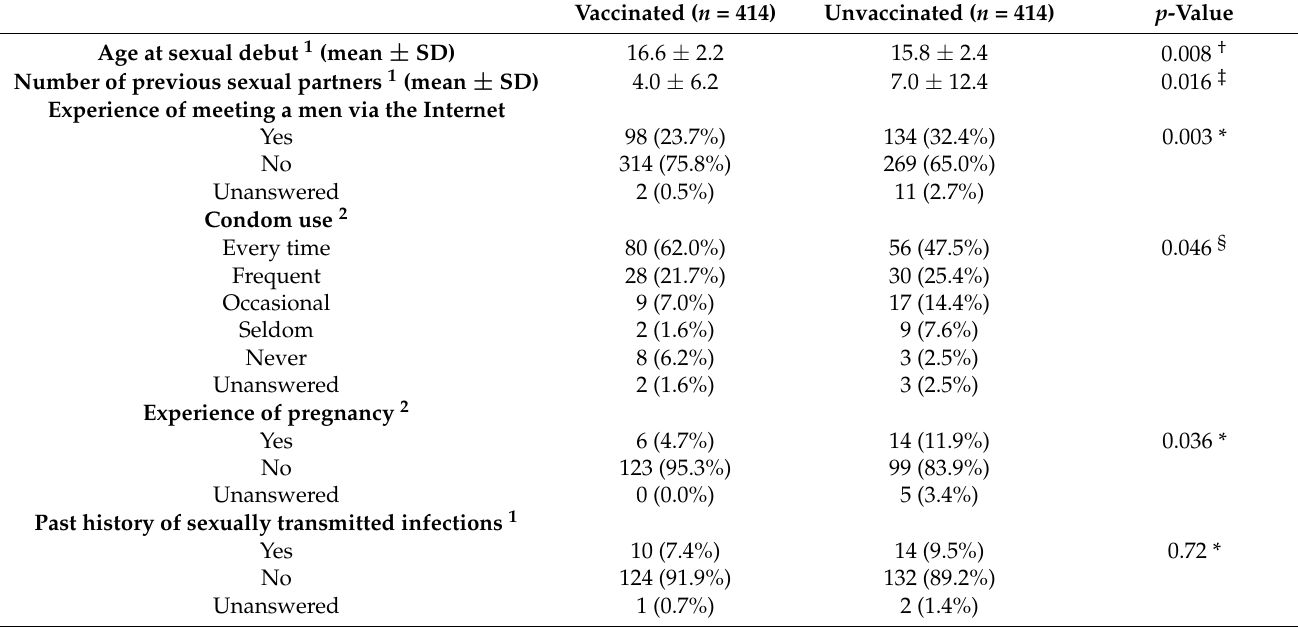
Table 3. Sexual activity and